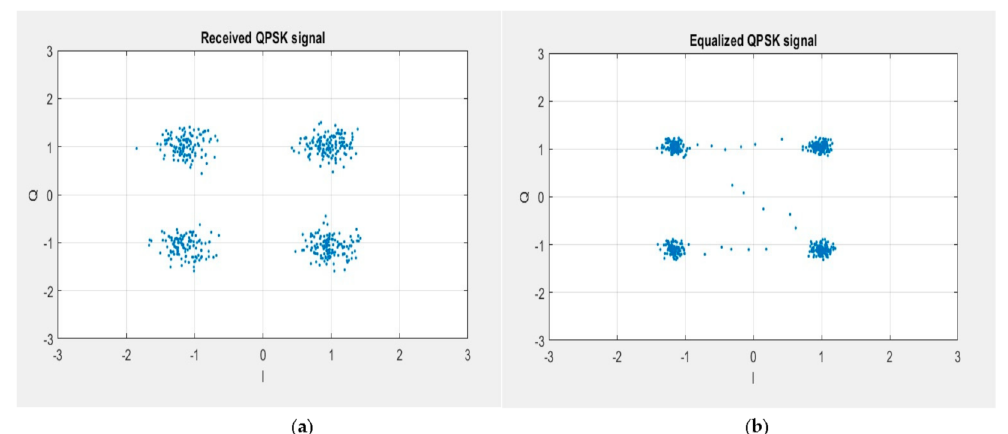
Figure 13. EVM measurements for QPSK modulation using CMA equalization (100 km SMF link). ( a ) Constellation diagram for QPSK before equalization with EVM 18.7%. ( b ) Constellation diagram for QPSK after CMA equalization with EVM 15%.